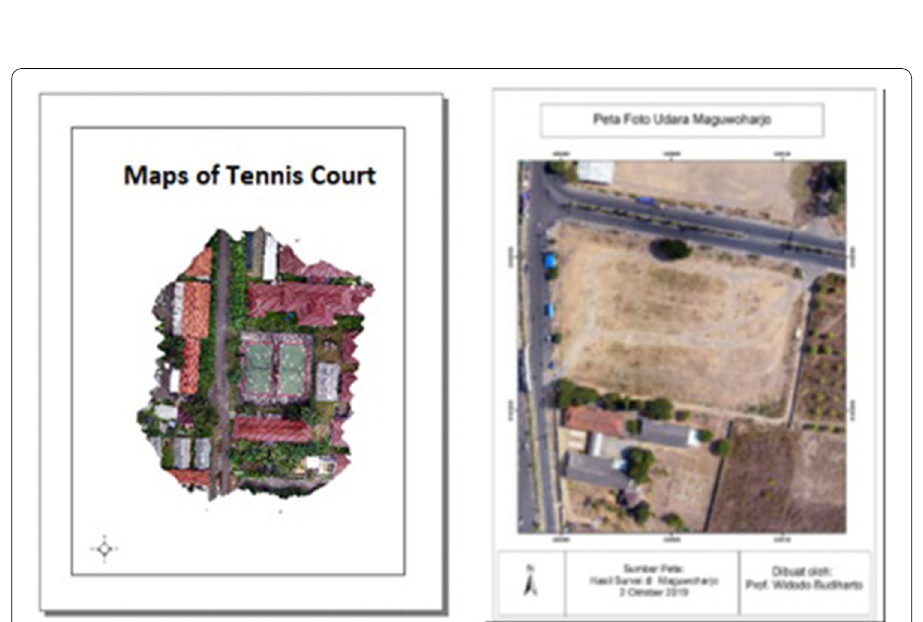
Fig. 6 Ortho mosaic photo and calculating area in Tennis Court in Bogor ( a ) and b area open field in Maguwo, Yogyakarta, Indonesia